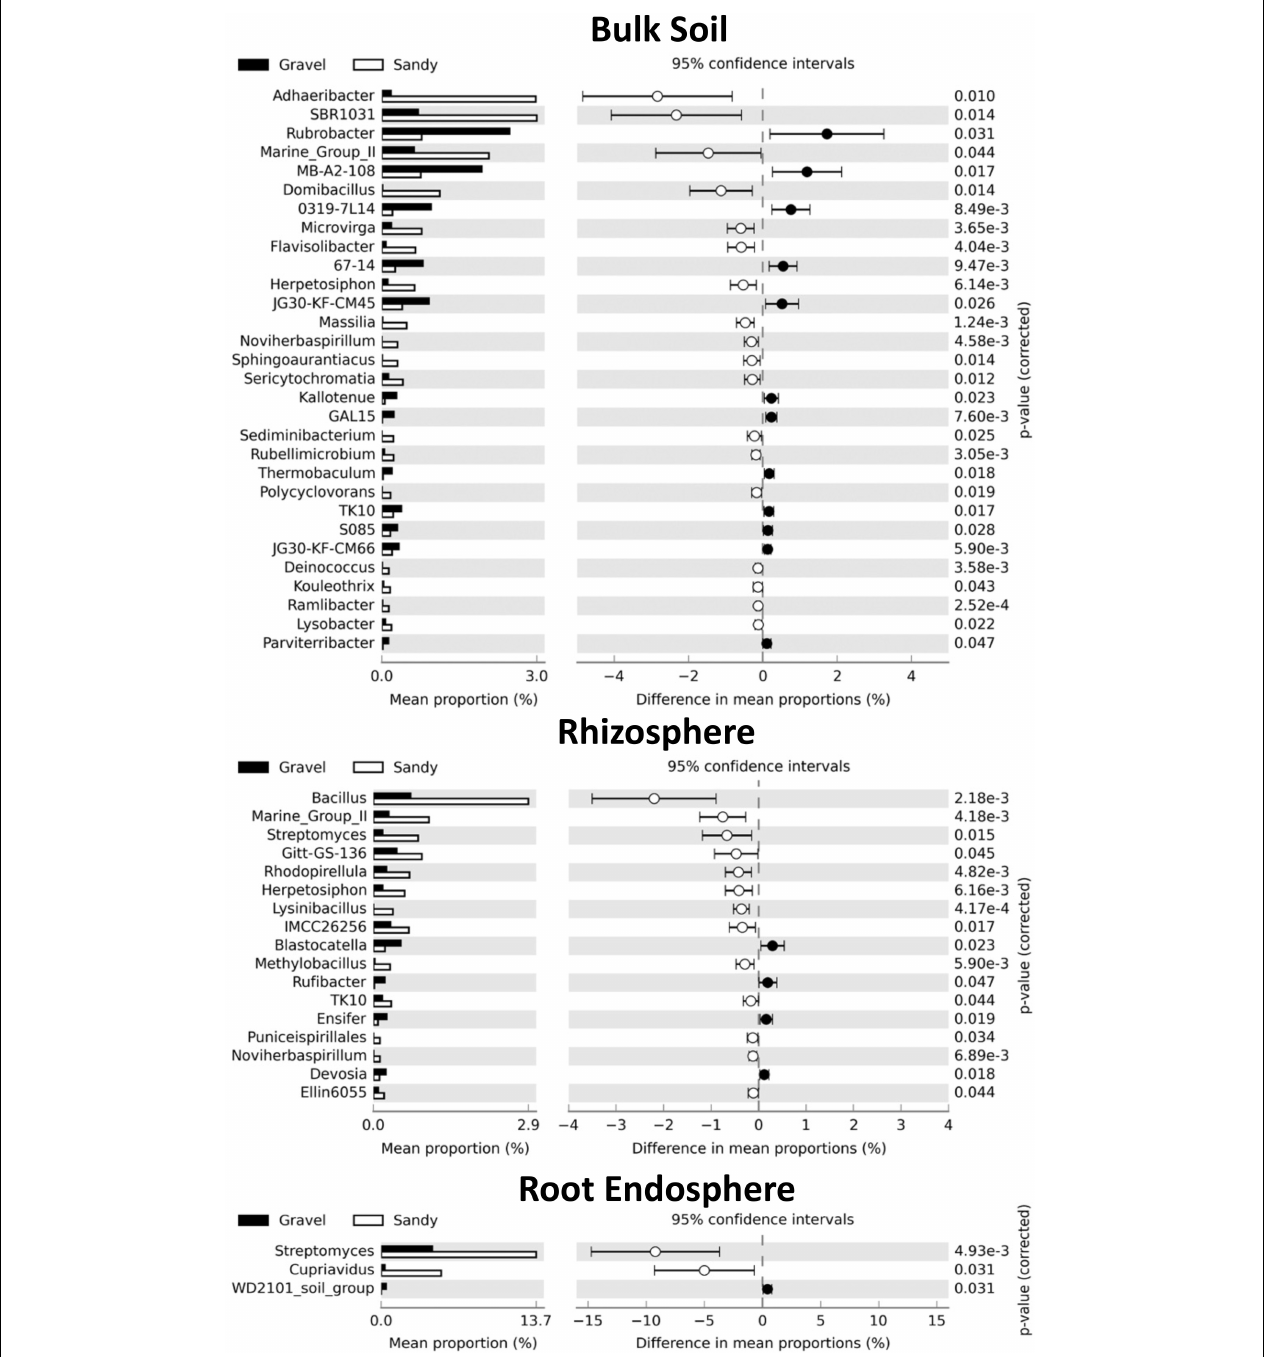
FIGURE 6 | Differences in the relative abundance of specific bacterial genera between the two soil types in each compartment. Set of bacterial genera that significantly shifted in relative abundance according to the Kruskal-Wallis’s test with the Bonferroni p -value correction ( p < 0.05) in each sampling compartment. The genera are sorted based on the largest differences in the mean proportion of sequences between samples collected from gravel (black) and sandy (white) soils. The shoot endosphere was not shown in the figure because no significant differences were found in this compartment.